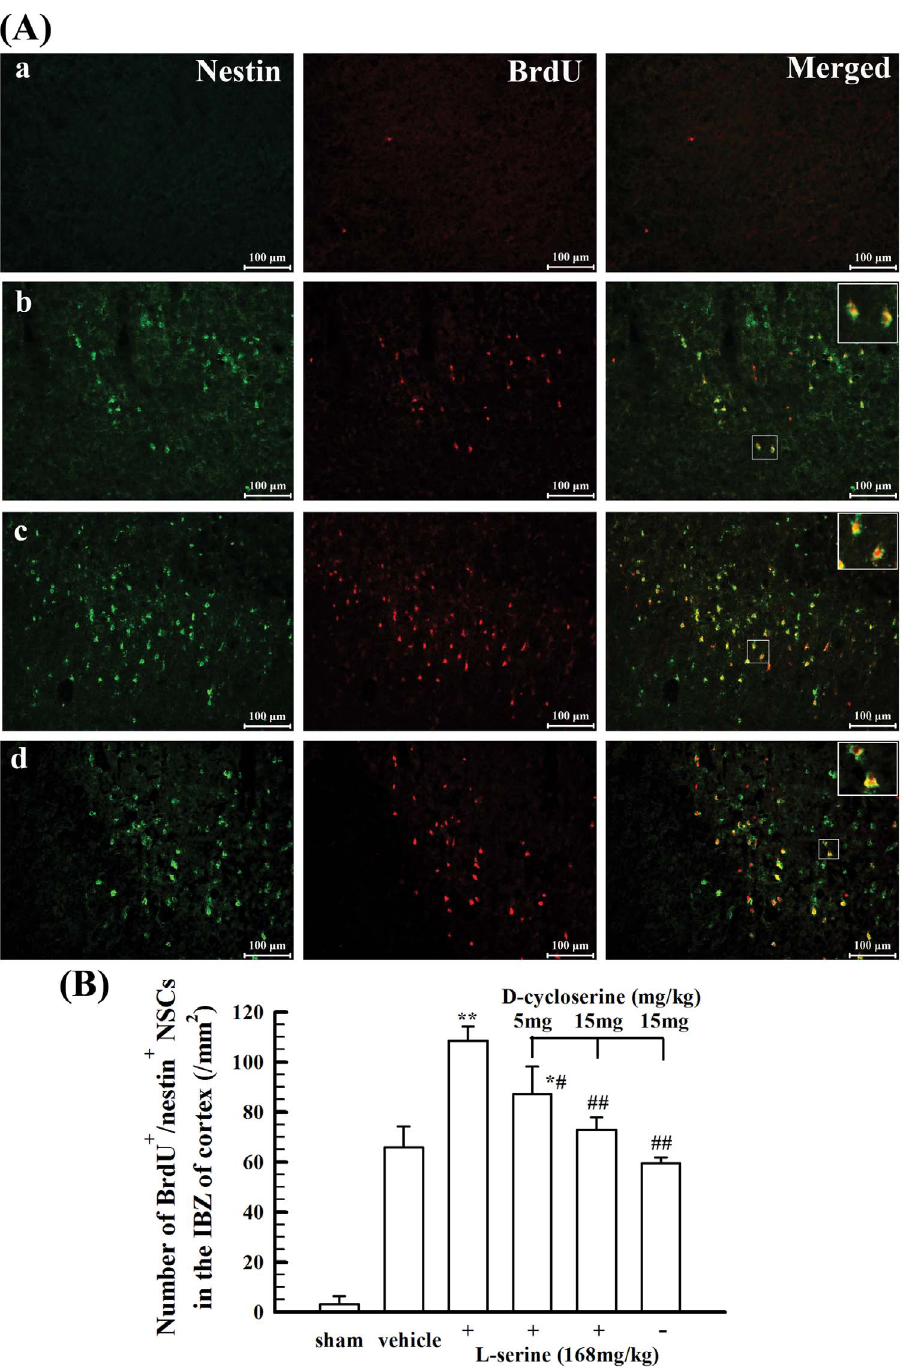
Figure 6. Effect of L-serine treatment on endogenous NSC proliferation in the IBZ of cortex 6 days after pMCAO. (A) Representative examples of BrdU- and nestin-positive cells: a, sham-operated group; b, vehicle group; c, L-serine (168 mg/kg) treated group; d, L-serine (168 mg/kg) and D-cycloserine (15 mg/kg) treated group. (B) Mean values of the number of BrdU + /nestin + NSCs in the IBZ of cortex (n=4–6). * p , 0.05, ** p , 0.01 vs. vehicle group; # p , 0.05, ## p , 0.01 vs. L-serine-treated group.